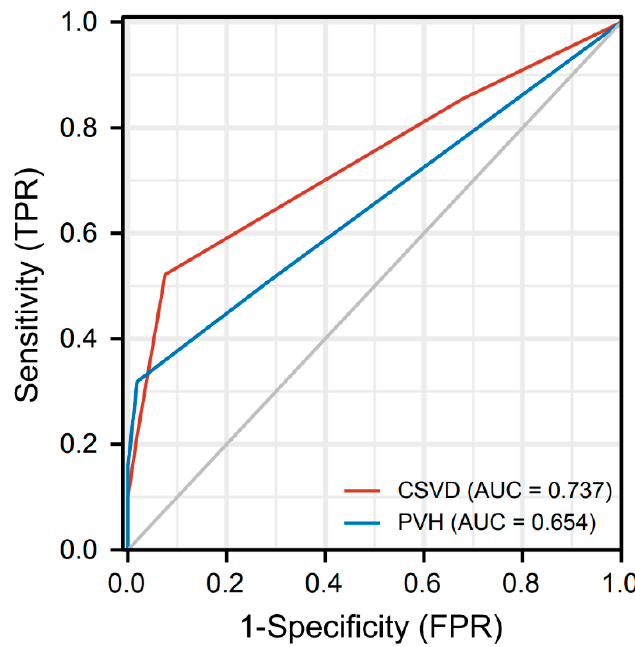
Figure 5. ROC Curve Analysis of the total burden of CSVD and PVH in identification of the PD patients with or without cognitive impairment. ROC: Receiver-operating characteristic; CSVD: cerebral small vessel disease; PVH: periventricular hyperintensities.